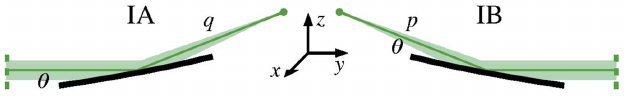
Figure 3 The Type IA paraboloids focus a collimated beam incident parallel to the y -axis. Type IB collimates light from an off-axis point source at distance p .